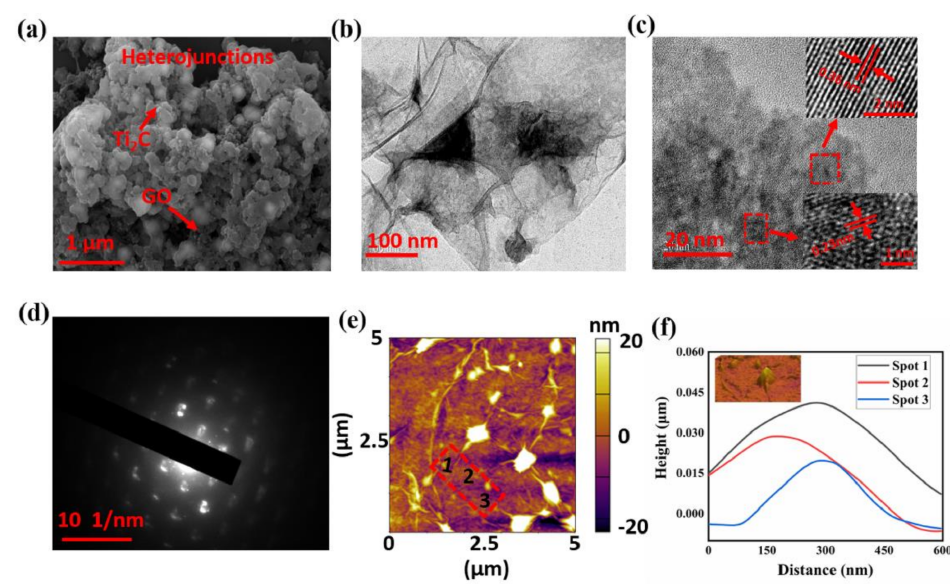
Figure 3. Morphological and structural characterization of the heterojunction: ( a ) SEM image of the heterojunction; ( b ) TEM image of the heterojunction; ( c ) high-resolution transmission electron mi- croscopy (HR-TEM) image of the heterojunction: top right corner and bottom right corner show two different lattice distances; ( d ) selective area electron diffraction (SAED) pattern of the heterojunction; ( e ) atomic force microscopy (AFM) image of the heterojunction; ( f ) corresponding height profiles of the